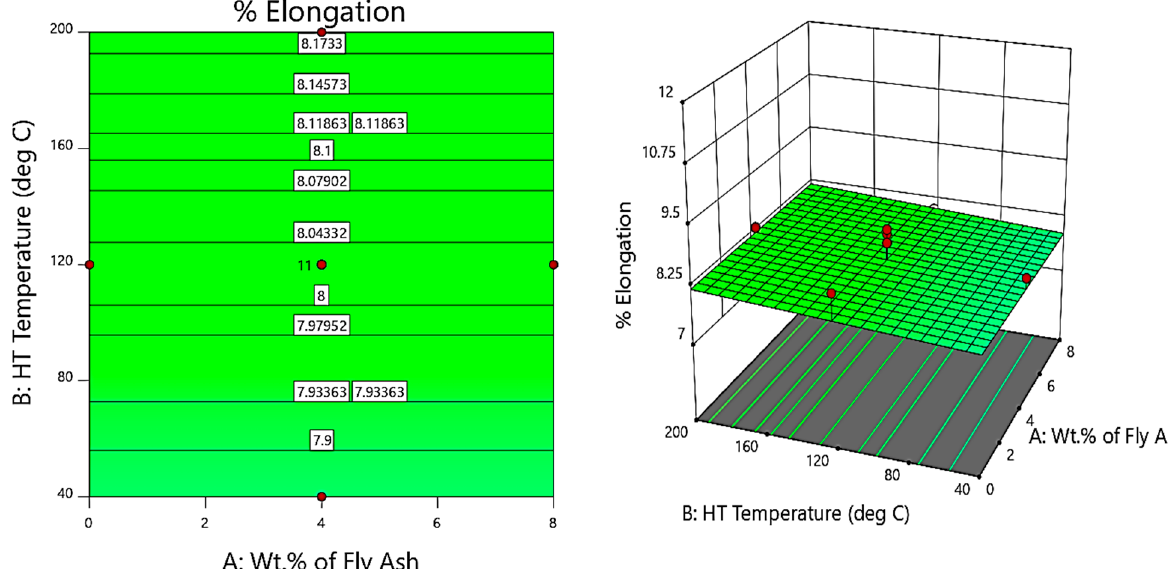
Figure 20. Contour and 3D Surface plots for variation of % elongation with varying wt.% of fly ash and HT temperature. From the contour and 3D surface plots for variation of % elongation with varying wt.%